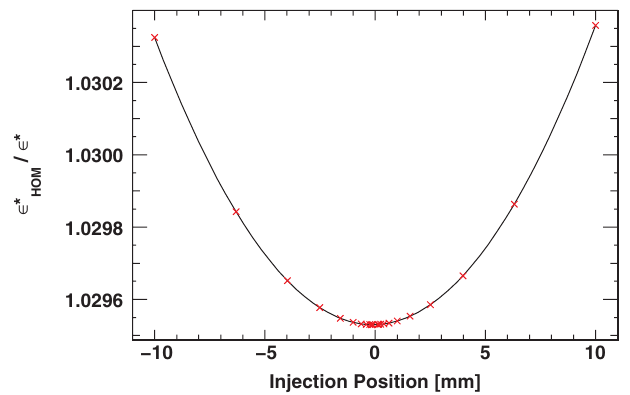
FIG. 33. Average (cid:6) (cid:5) growth in case of an off-axis injected beam with a HOM present and normalized with same off-axis beam without HOMs. The phase space increases with the injec- tion offset, but is fare less than the deviation (cid:5) ð (cid:6) (cid:5) Þ ¼ 0 : 28% introduced by different HOM frequency patterns. Settings: N ¼ 100 , see Table IX.